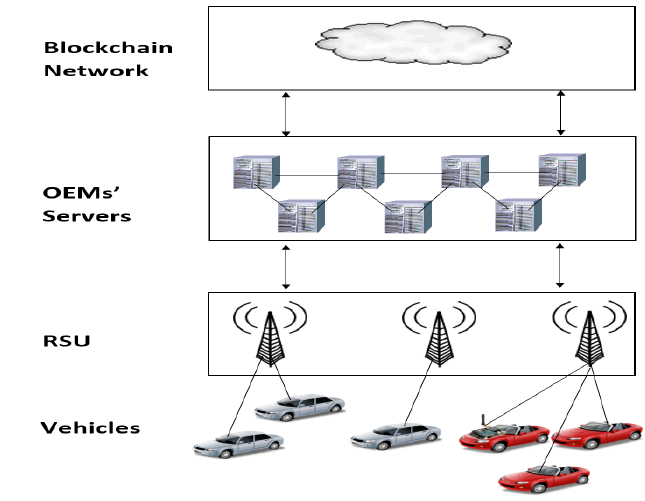
Figure 9. The proposed system in real